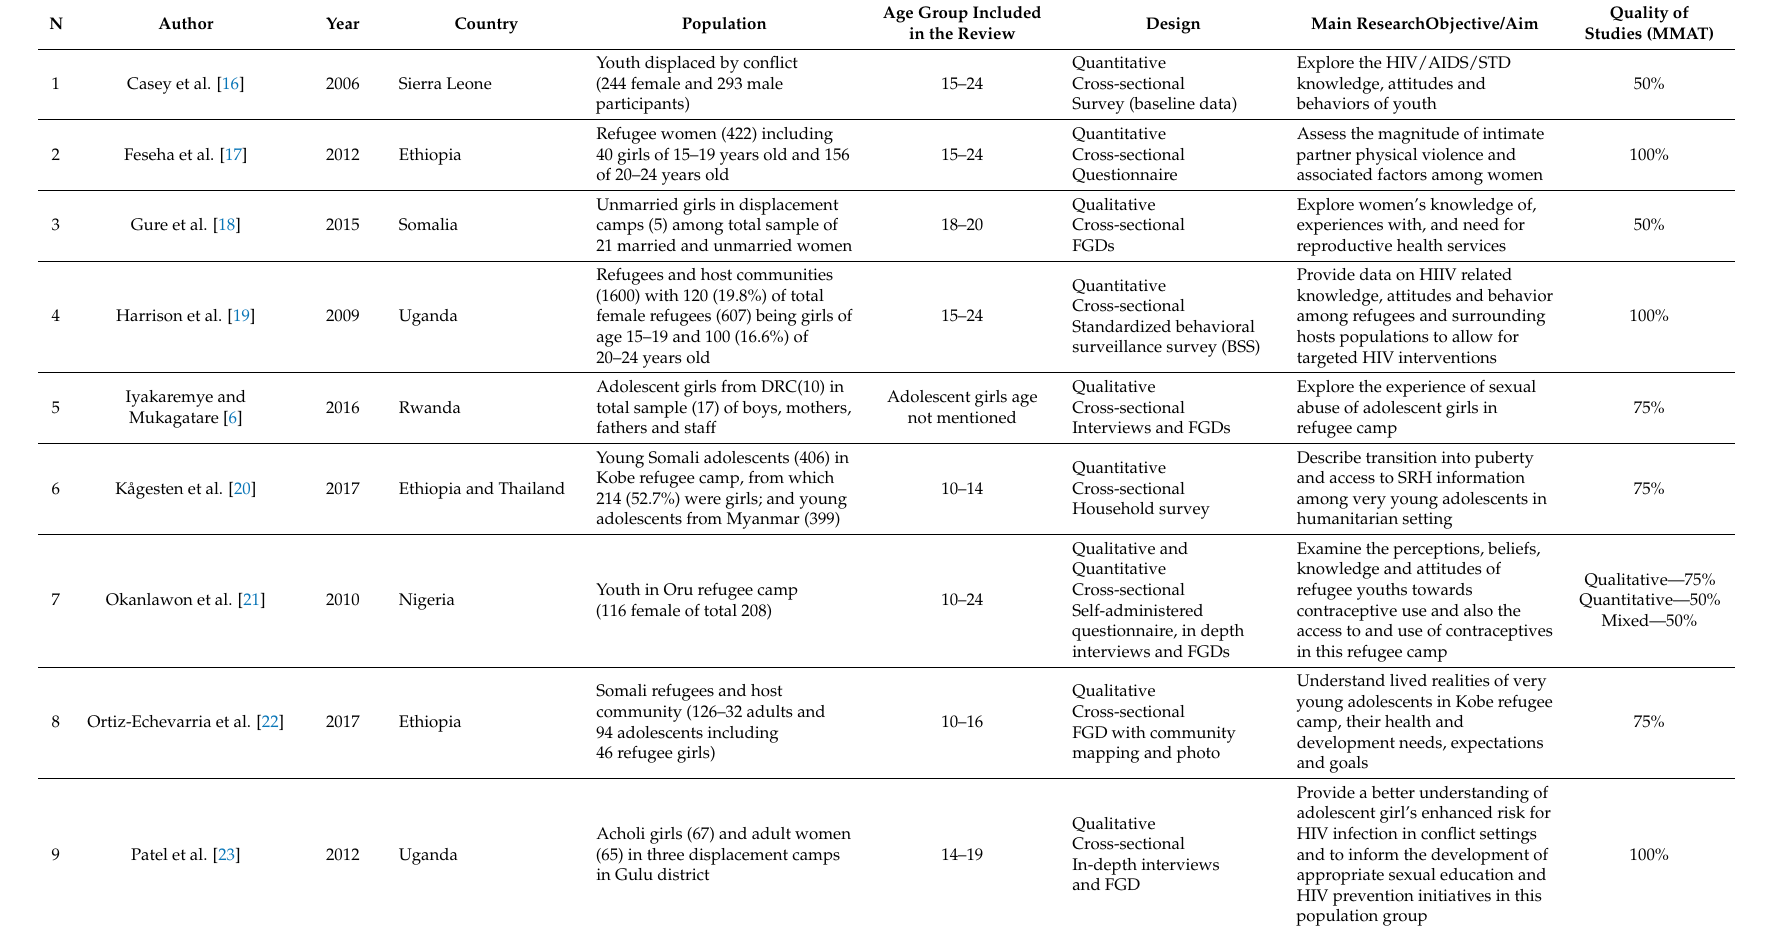
Table 2. Characteristics of studies included in the